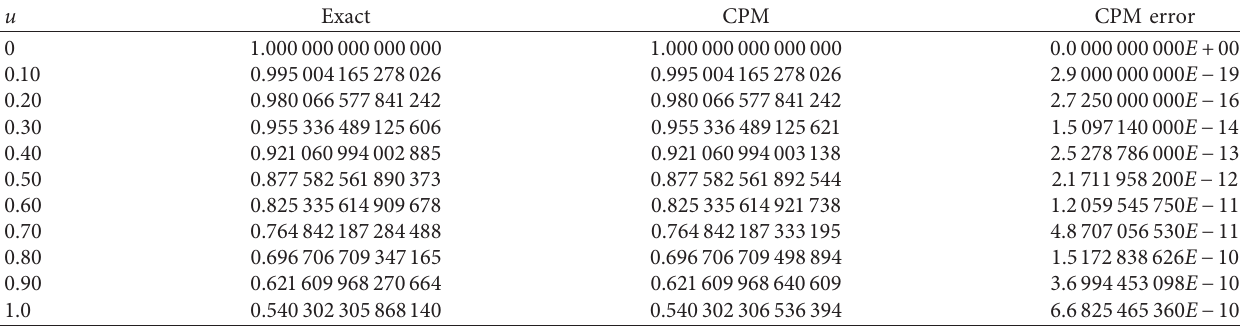
Table 3: Exact, CPM solution, and CPM A.E of problem 2 at m � 10.